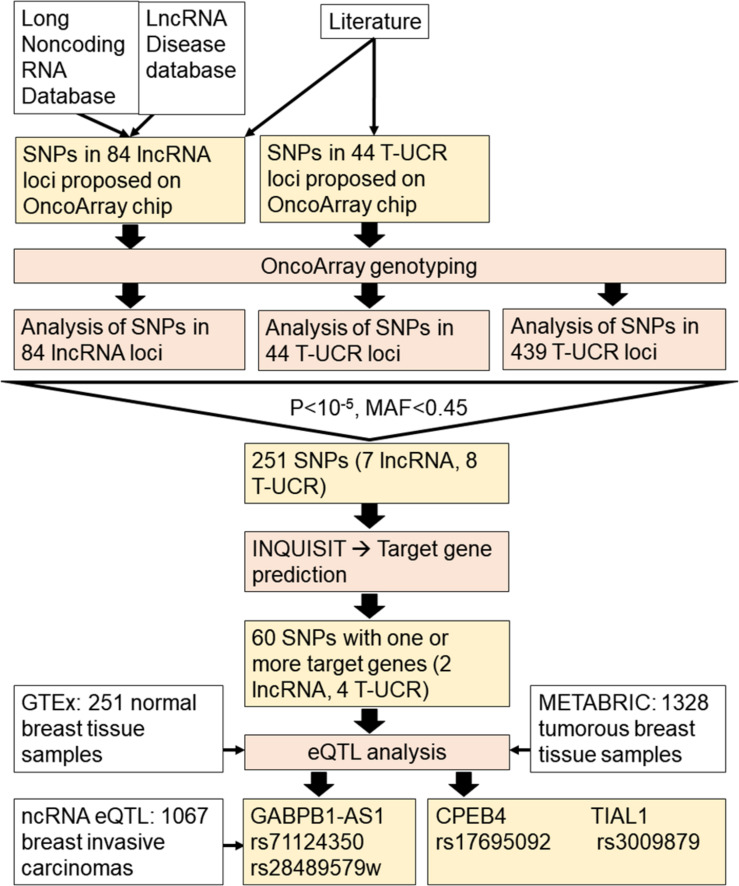
Workflow chart of the study.